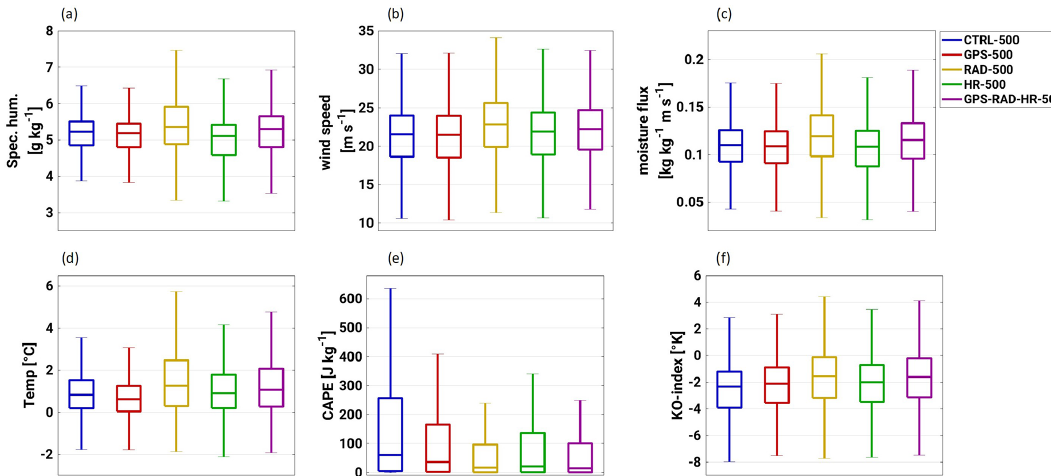
Figure 10. Box-and-whisker plots showing the median, quartiles, and extremes of specific humidity (a) , wind speed (b) , moisture flux (c) , temperature (d) , CAPE (e) , and KO index (f) at 700hPa. All the values have been obtained from hourly COSMO output between 05:00UTC and 10:00UTC of 24 September 2012 over the study region